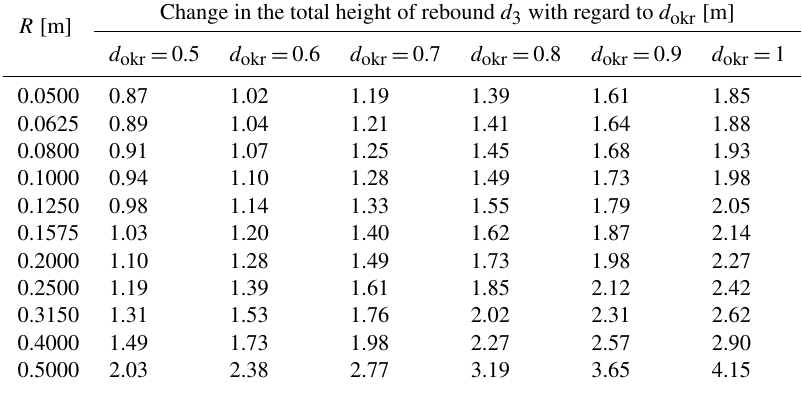
Table 5. Change in rebound height d 3 with regard to d okr by v 1 = 4ms − 1 . Change in the total height of rebound d 3 with regard to d okr [m] R [m] d okr = 0.5 d okr = 0.6 d okr = 0.7 d okr = 0.8 d okr = 0.9 d okr =